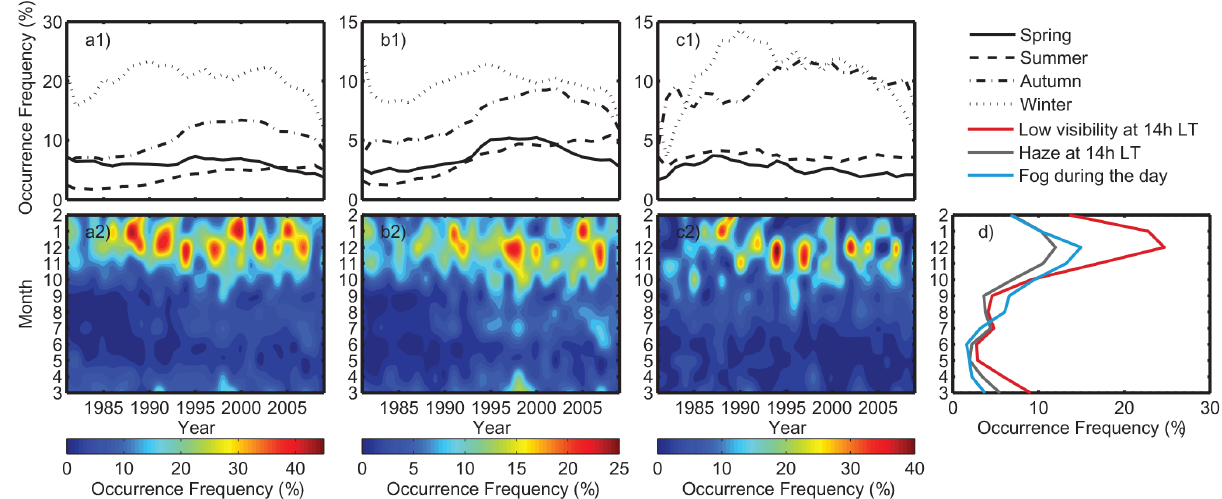
Figure 4. (1) The trend of the 10-year moving average frequency of occurrence of (a) low-visibility events at 14:00LT, (b) haze events at 14:00LT and (c) fog events during the day among the 64 stations during spring (MAM), summer (JJA), autumn (SON) and winter (DJF). (2) The seasonal–annual variation of the average frequency of occurrence of (a) low-visibility events at 14:00LT, (b) haze events at 14:00LT and (c) fog events during the day among the 64 stations and (d) the seasonal variation of the average frequency of occurrence of low-visibility events at 14:00LT, haze events at 14:00LT and fog events among the 64 stations during 1981–2010.